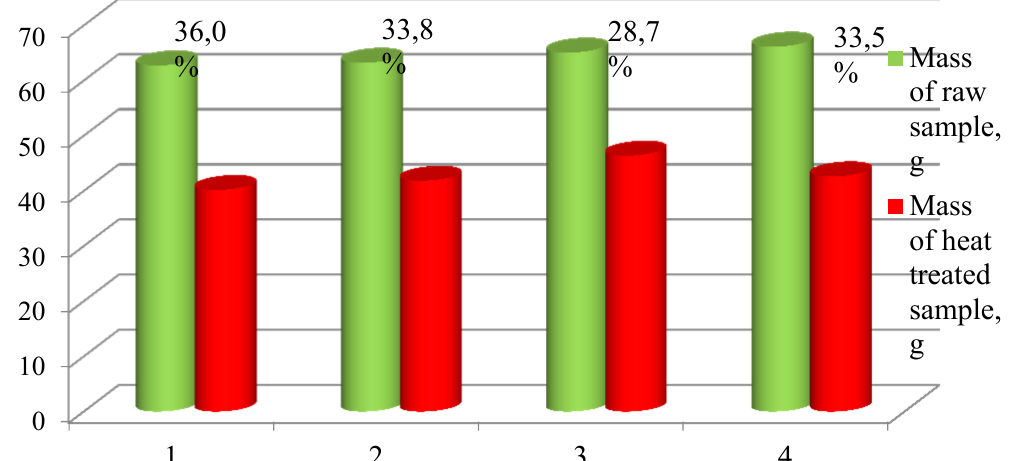
Figure 1. The yield of minced meat semi-prepared meat products after thermal treatment. 1 – „mici” from sheep and poultry meat (70:30) –control sample; 2 – „mici” from sheep and poultry meat (70:30) with 7% walnut groats and 2% wheat fibers; 3 – „mici” from sheep and poultry meat (70:30) with 7% added pumpkin seed groats and 2% wheat fibers; 4 – „mici” from sheep and poultry meat (70:30) with 7% sesame seed groats and 2% wheat